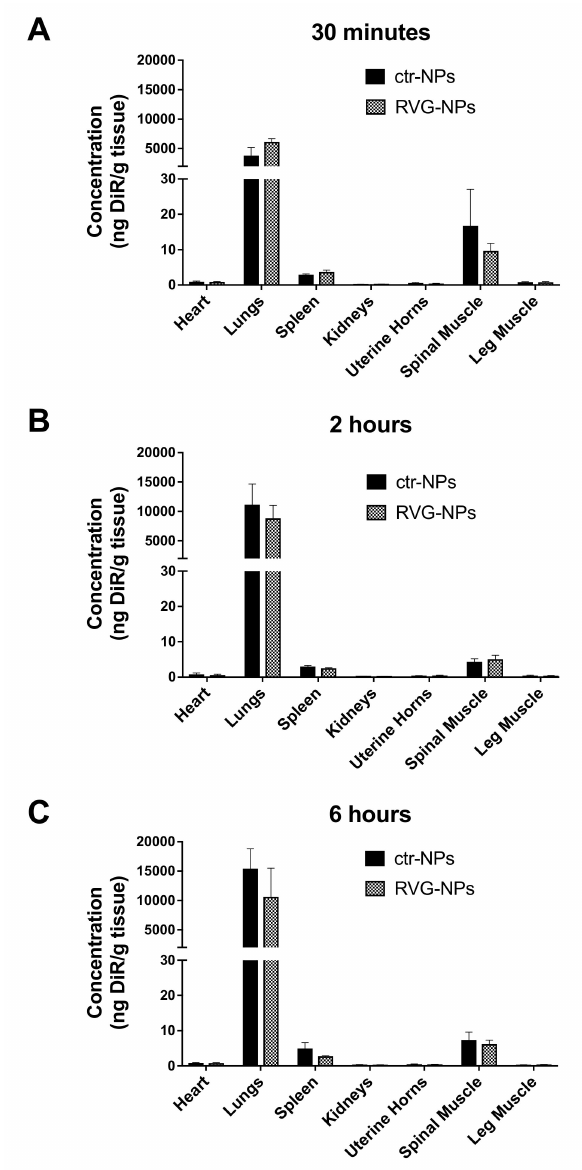
Figure 3. Biodistribution of DiR-loaded PLGA nanoparticles following intranasal administration. DiR concentration was measured in peripheral organs. ( A ) 0.5 h, ( B ) 2 h, ( C ) 6 h. Graphs show the mean ± SEM ( n =